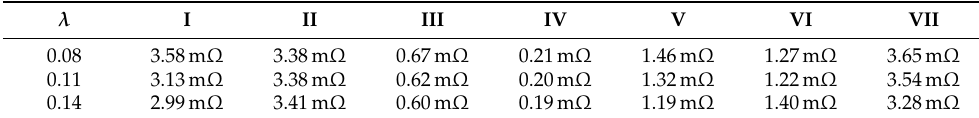
Table A2. Distribution of gains for the different processes of the BOL measurement obtained by